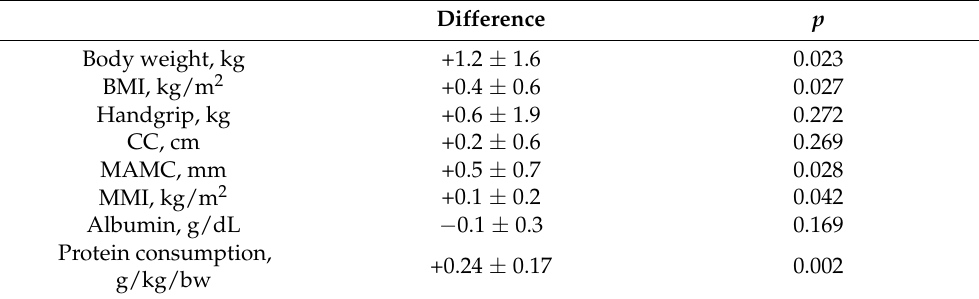
Table 2. Observed change in anthropometric and protein balance parameters among pre-frail patients who finished nutritional intervention ( n =